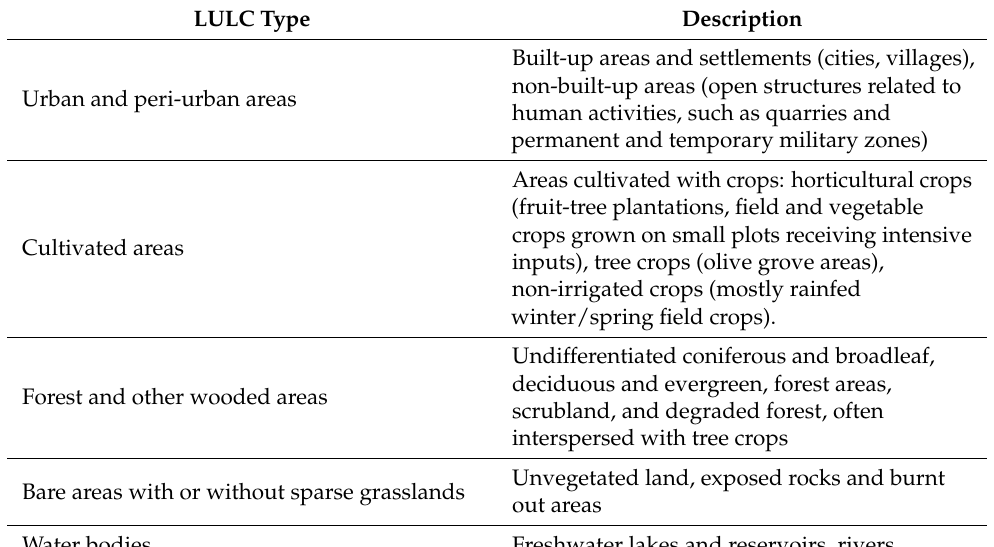
Table 3. Detailed description of land use/cover types in the Syrian coast region